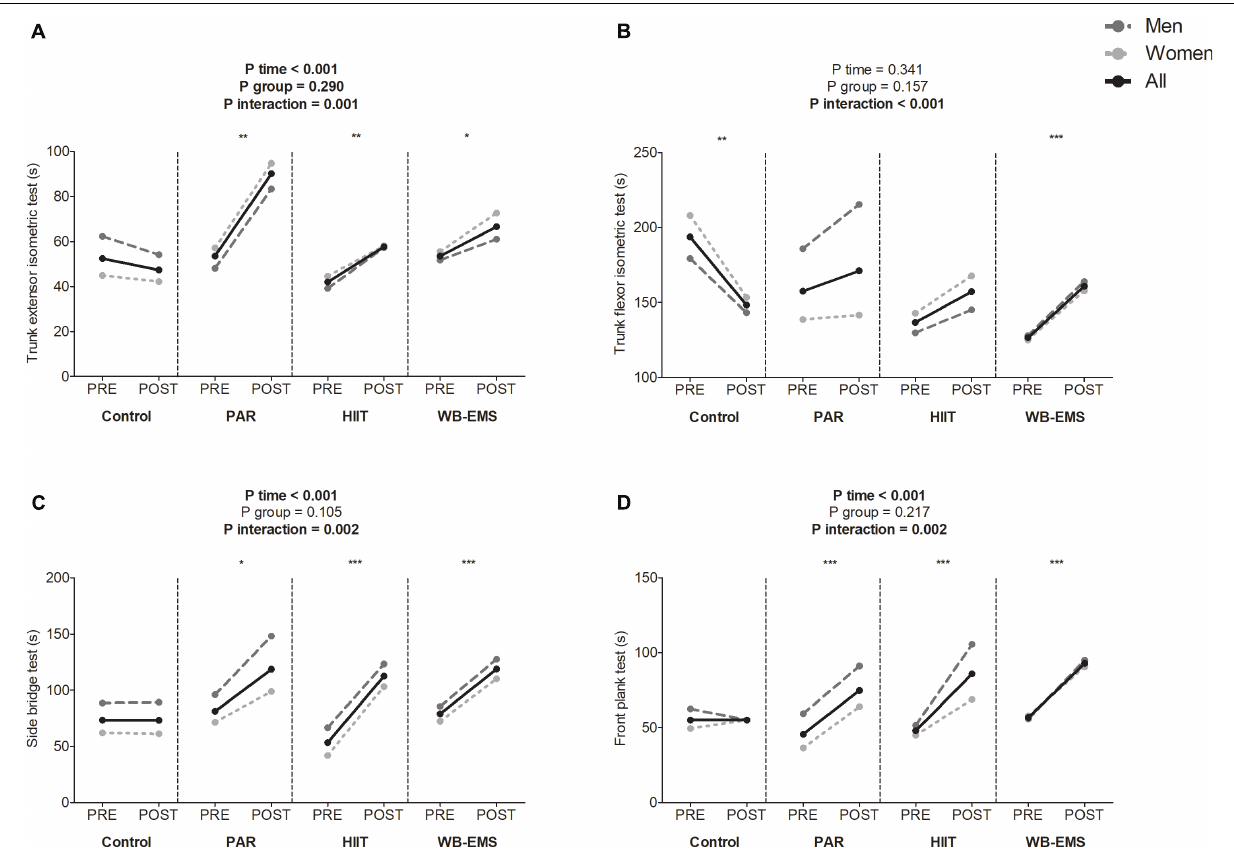
FIGURE 4 | Changes in the trunk extensor isometric test (A) , trunk flexor isometric test (B) , side bridge test (C) , and front plank test (D) values before and after the intervention study. P -value [time, group, and interaction (time ∗ group)] of repeated measures analysis of variance. ∗ P < 0.05, ∗∗ P < 0.01, ∗∗∗ P < 0.001 obtained by Student’s paired t -test. PAR, physical activity recommendations for adults proposed by the World Health Organization group; HIIT, high intensity interval training group; WB-EMS, whole-body electromyostimulation